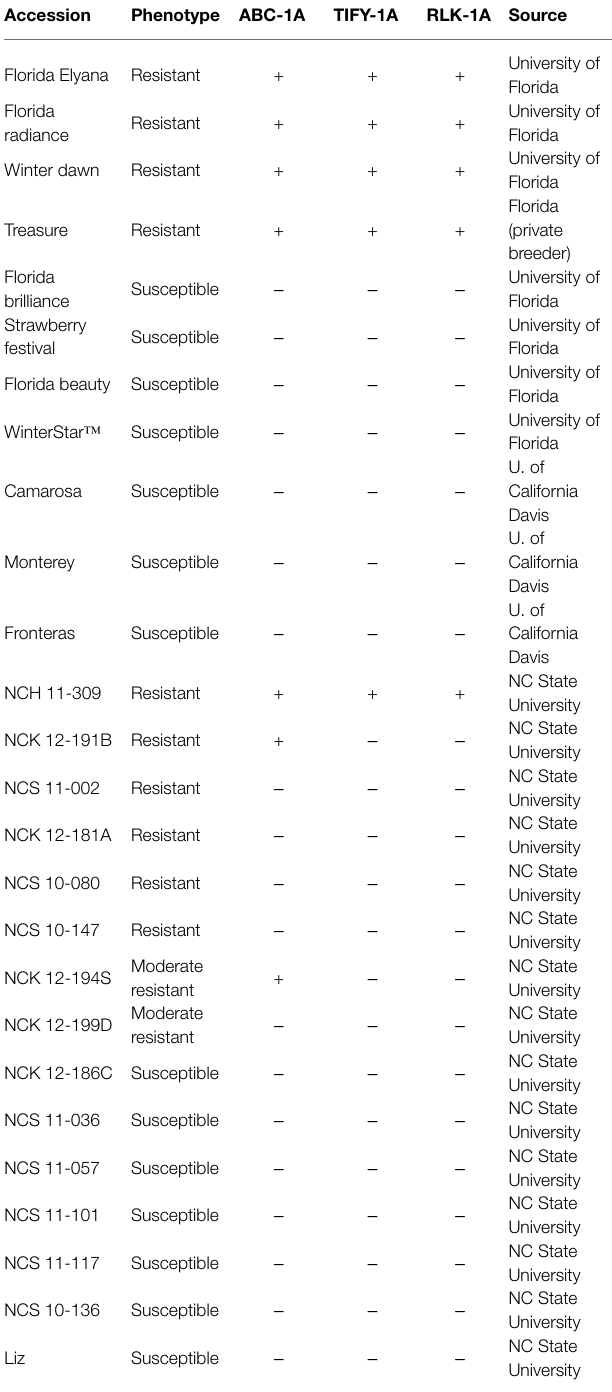
TABLE 1 | Colletotrichum crown rot (CCR) phenotype and three newly developed high-resolution melting (HRM) marker genotype data of 30 selected